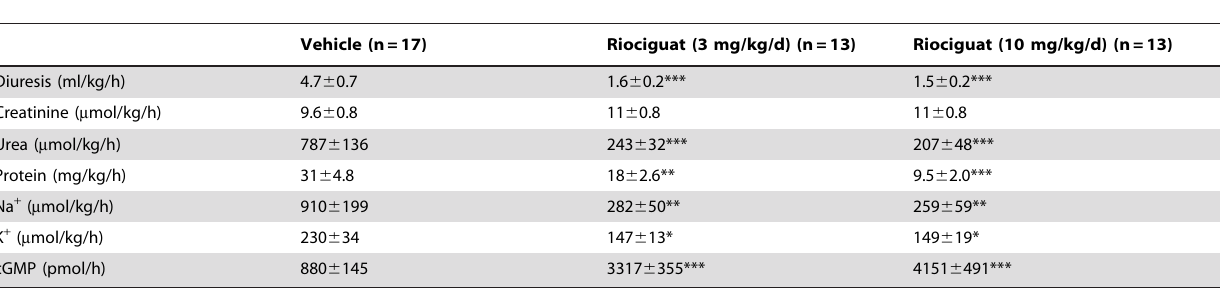
Table 4. Parameters of renal function in the vehicle- and riociguat-treated Dahl/ss rats maintained on a high-salt diet.